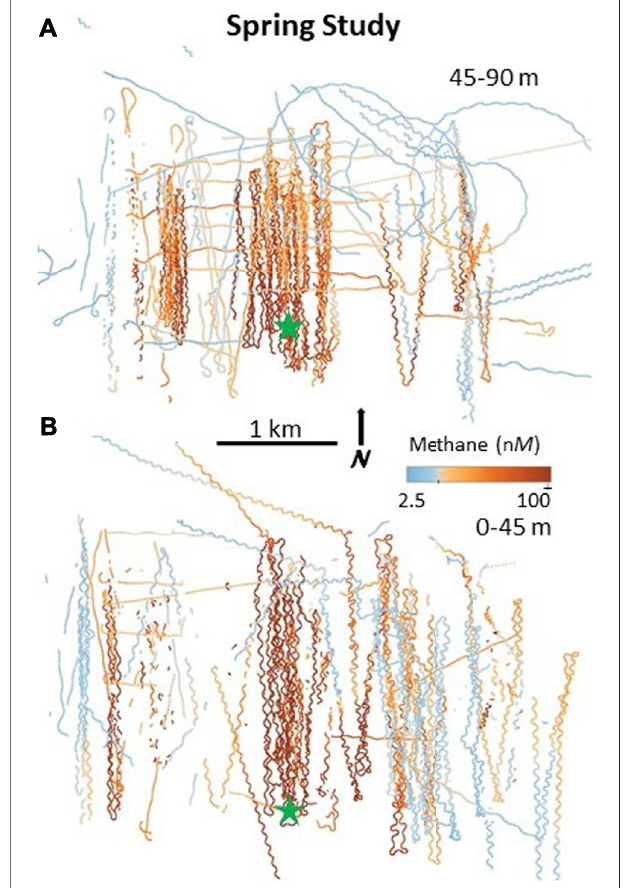
FIGURE7| Glidertraverse mapsfordatacollectedinthespringstudyof the Bush Hill area (green star marks seep) color coded for methane concentration. (A) shows the data binned between 45 and 90 m and (B) 0 – 45 m above the sea fl oor. The divergence in the methane color coding corresponds to the 25 n M or 10 × the environmental background with orange colors indicating con fi dent methane